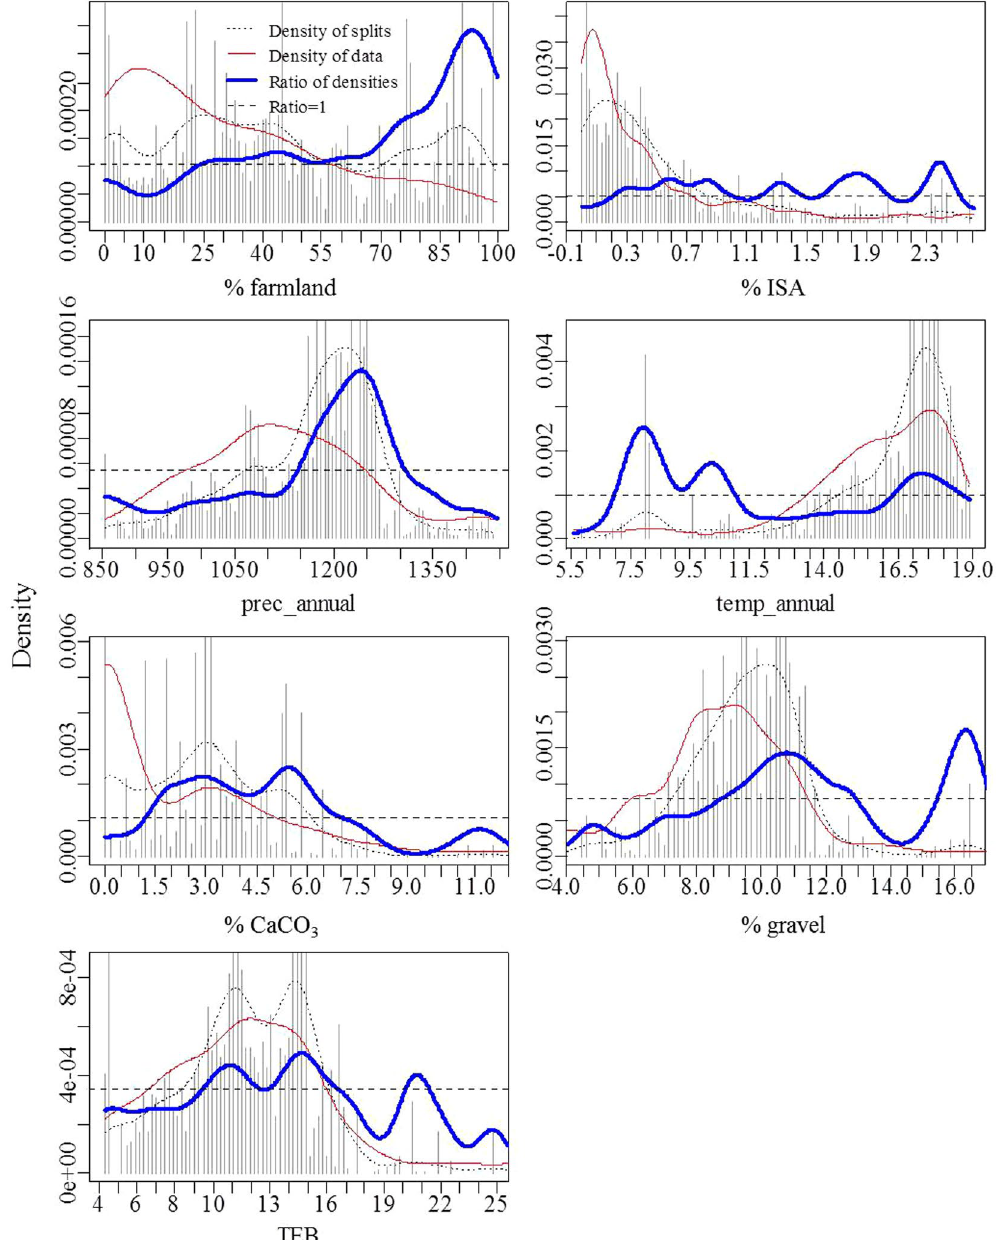
Figure 4. Compositional changes of benthic diatom assemblages across individual gradient of human land use and important natural environmental variables in tributaries of the Three Gorges Reservoir. Blue lines indicate ratios between binned raw importance density (gray vertical lines) and densities of observed predictor values (red lines) with horizontal dashed lines representing ratios = 1. Ratios > 1 indicate steep changes. The cross points between the blue and dashed lines where subsequent ratios > 1 were identified as thresholds. For the full names of each variable, please see Table